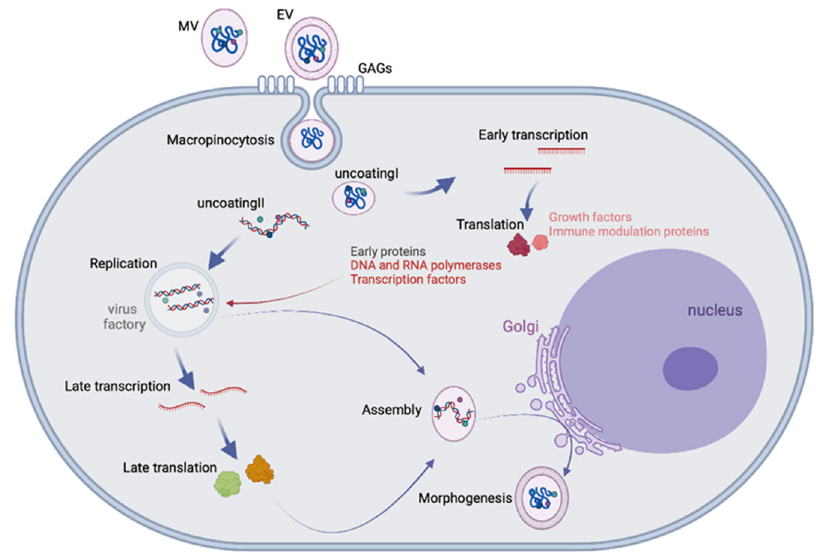
Figure 2. Orthopoxvirus replication